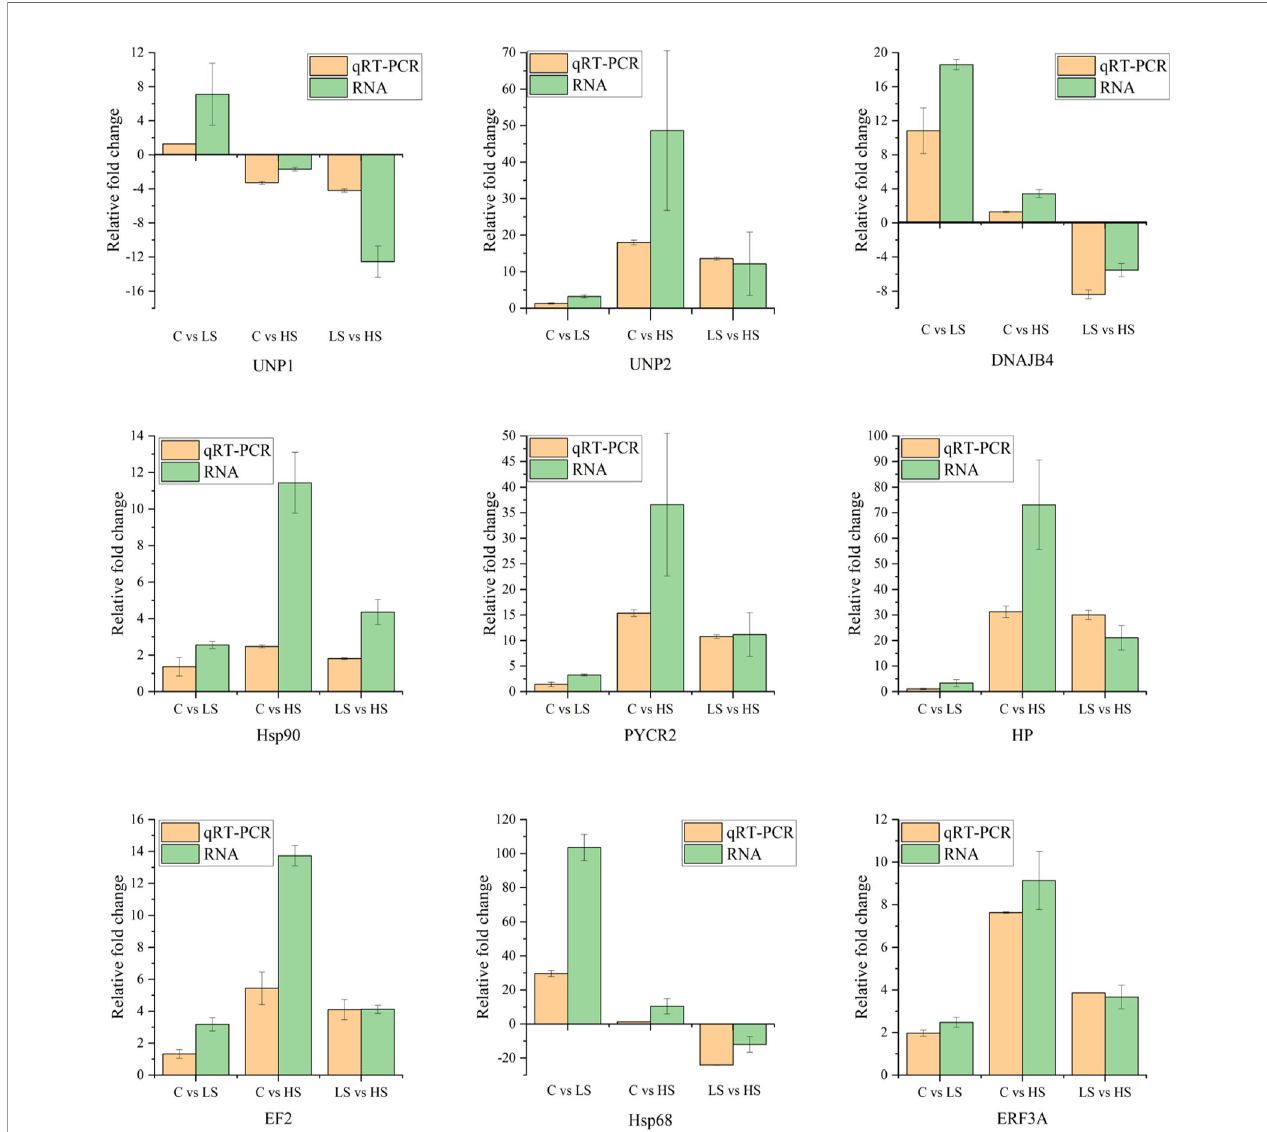
FIGURE 7 | Veri fi cation of the selected 9 DEGs by quantitative real-time PCR as compared with RNA-seq